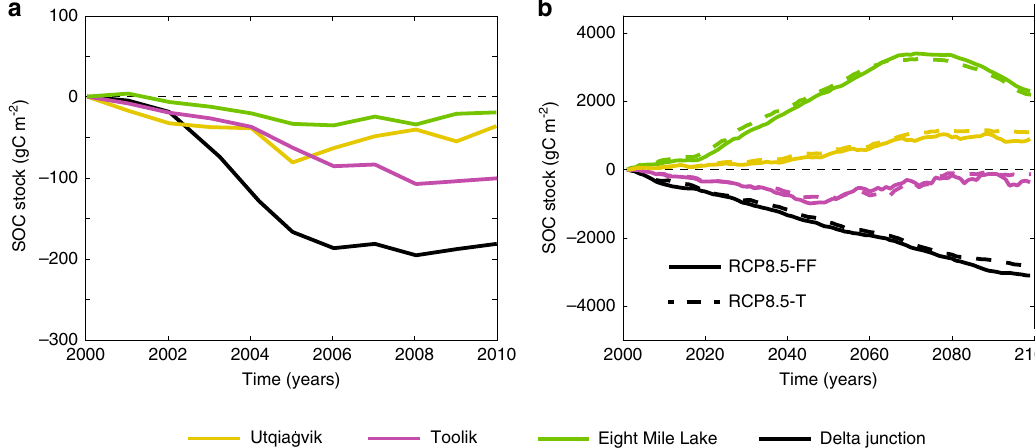
Fig. 2 Soil organic carbon stock trajectories differ between short and long-term warming. Soil organic stock trajectories under a short-term warming and b long-term perturbation simulations (warming only (RCP8.5-T) and fully forced (RCP8.5-FF)) for the 0 – 3 m soil pro fi le. Short- and long-term SOC stock trajectories have been normalized to unperturbed Table 3). Modeled whole soil pro fi le SOC stocks declined at all four sites (Fig. 2a). The extent of this 10-year decline differed by site, Table 4). Soil moisture also increased at all sites, although the with SOC loss being highest at Delta Junction (net carbon loss of increase was larger under RCP8.5-FF than RCP8.5-T due to a simulated rise in precipitation under RCP8.5-FF. Elevated soil water content increased soil thermal conductance, resulting in a deepening ALD modeled at all tundra sites. At Eight Mile Lake the ALD increased by over 1 m concurrent with a small increase in soil moisture across the soil pro fi le (Supplementary Table 2). Delta Junction, which is not underlain by permafrost, also had a